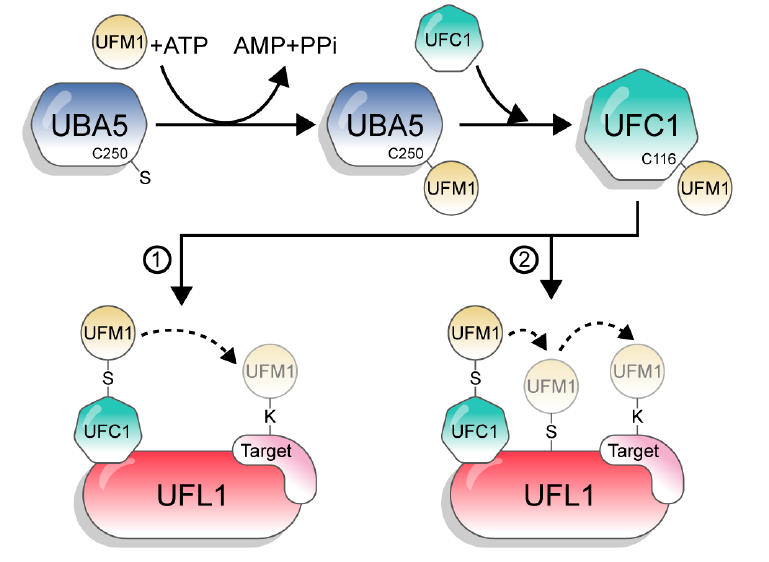
Figure 2. The UFM1 conjugation pathway. The figure depicts the two options of UFM1 transfer from UFC1 to the target. 1: directly to the substrate; 2: in a two-step mechanism, from UFC1 to UFL1 and then to the target.